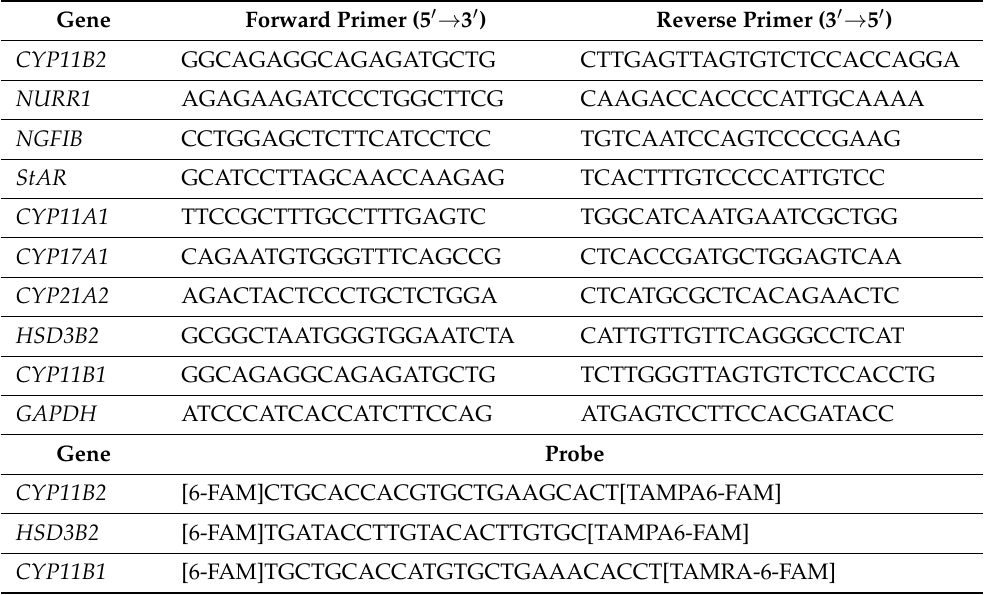
Table 1. Primer set using